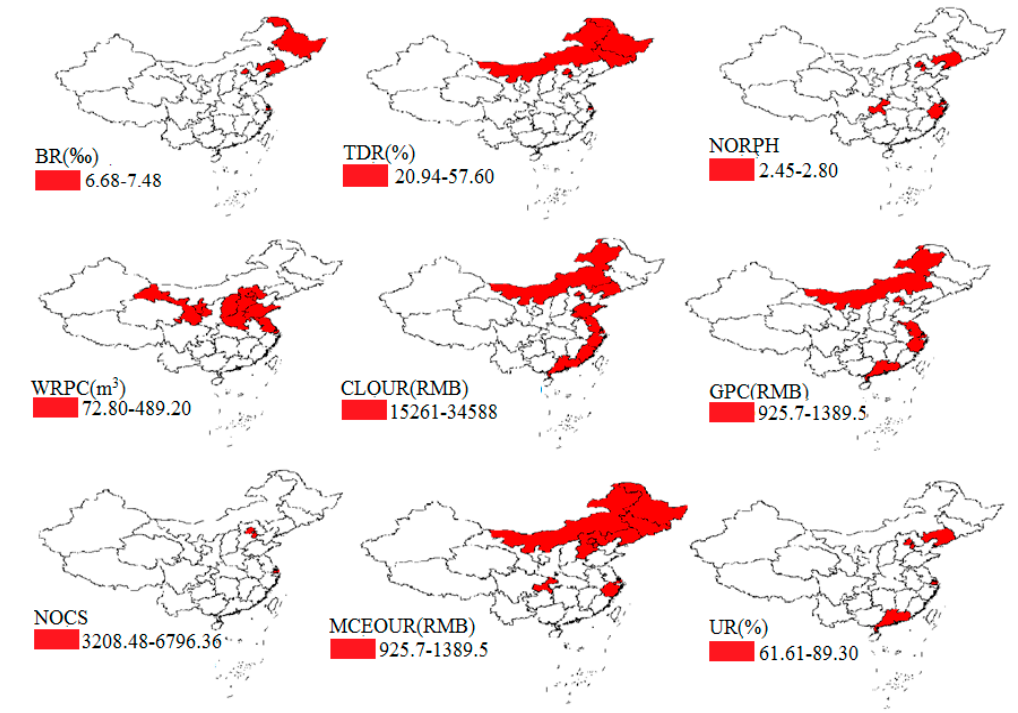
Figure 5. Distribution of main influencing area of each influencing factors. Table 7. Statistical significance of the di ff erences in PD values among di ff erent